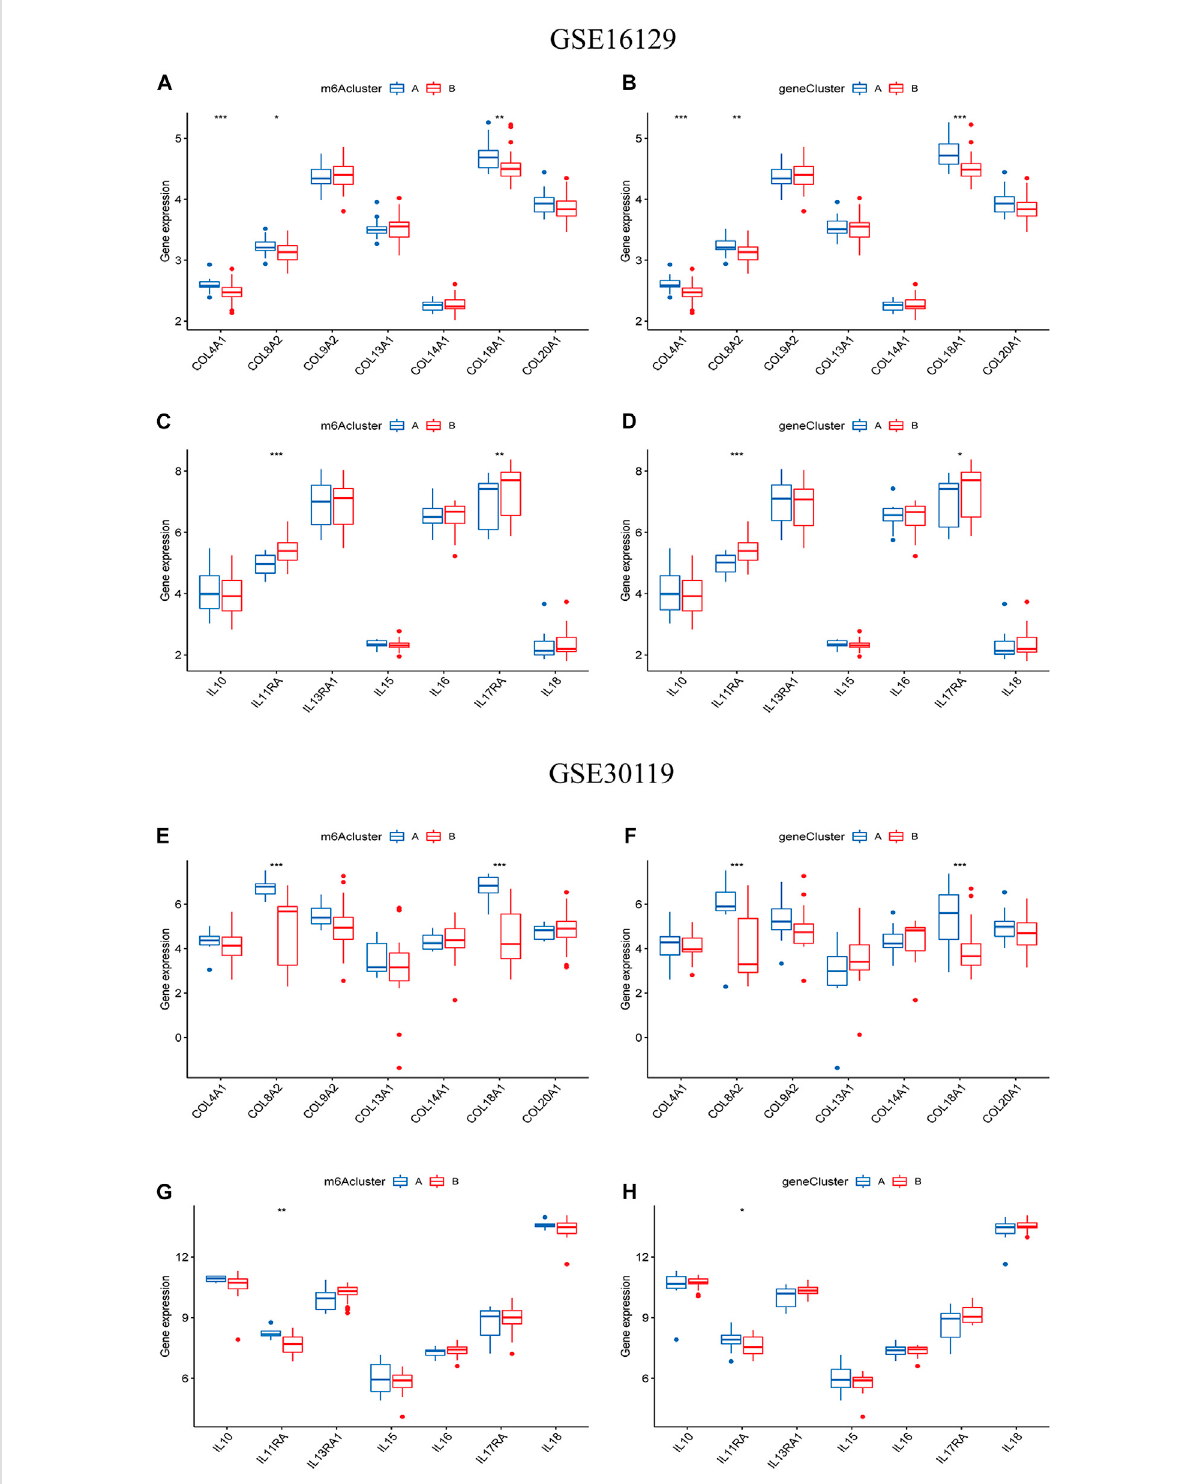
FIGURE 9 Differentialanalysisofcollagen-relatedandinterleukin-relatedgenesinthetwotypingmethods. Differentialanalysisofcollagen-relatedgenes between the two m6A (A) and two gene subgroups (B) based on the GSE16129. Differential analysis of interleukin-related genes between the two m6A (C) andtwogenesubgroups (D) basedontheGSE16129.Differential analysisofcollagen-relatedgenesbetweenthetwom6A (E) andtwogene subgroups (F) based on the GSE30119. Differential analysis of interleukin-related genes between the two m6A (G) and two gene subgroups (H) based on the